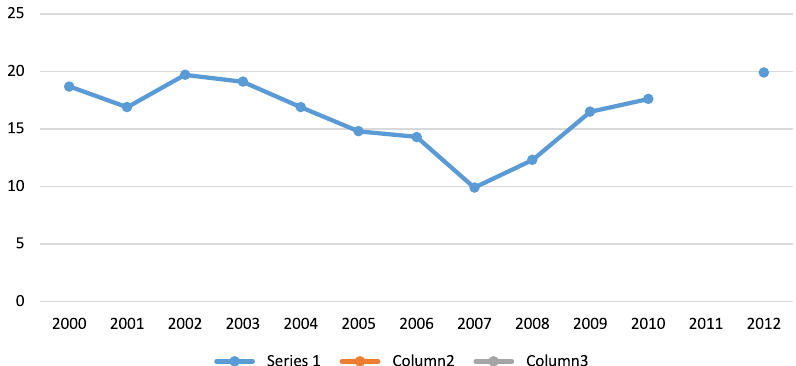
Fig. 2 Poverty headcount ratio at national poverty line (% of population), 2000 – 2012. Gives an indication of the percentage of the population living below the national poverty line. National estimates are based on population-weighted subgroup estimates from household surveys. Notes : At $1.90 a day (PPP 2011). Data for 2011 missing. Data sourced from the World Bank (https://data.worldbank.org/country/jamaica).